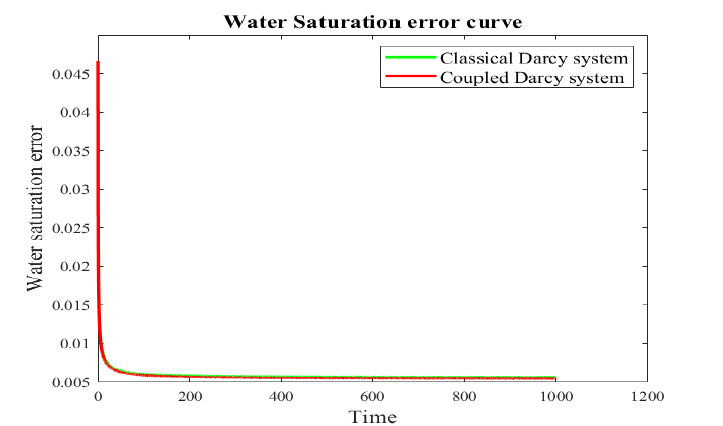
Figure 2. One-dimensional linear water saturation S w in terms of time t